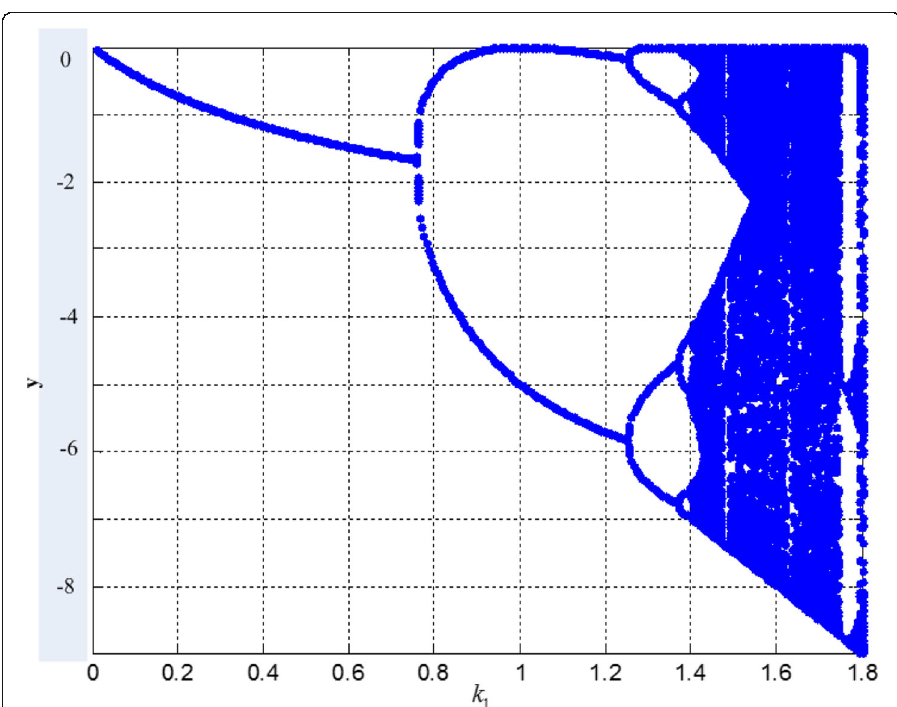
Fig. 5 The evolution chart of quantity decision making with k 1